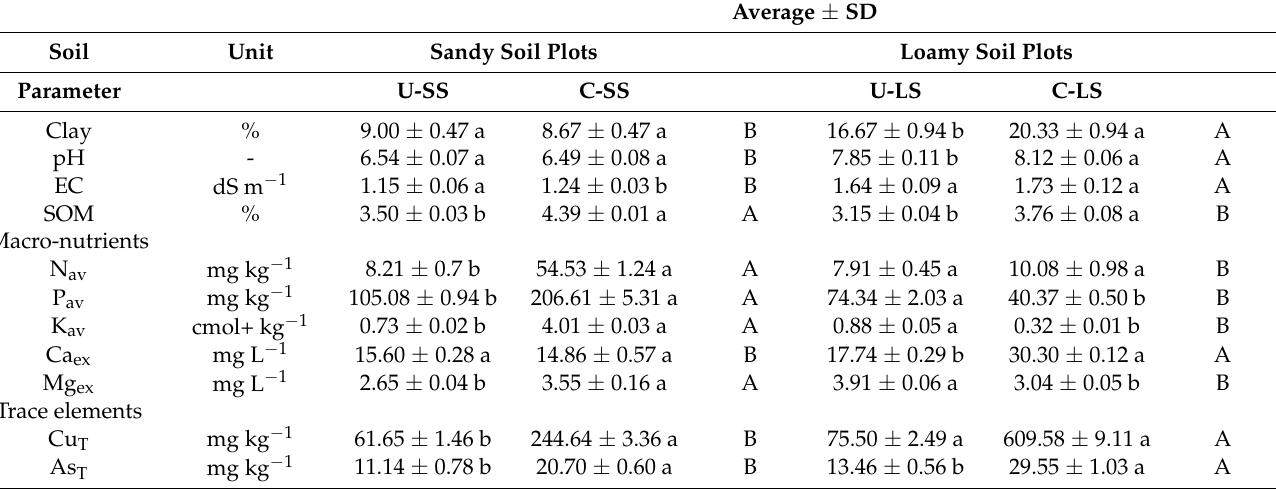
Table 1. Average ± SD of general physicochemical properties of the studied soils before amendment application ( n =